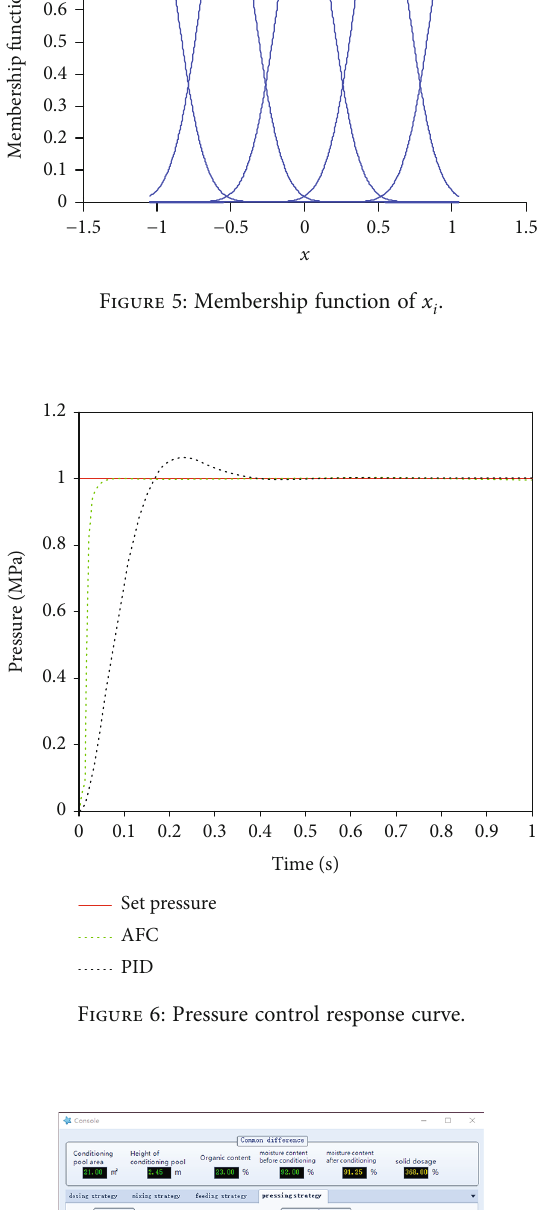
Figure 6: Pressure control response curve.